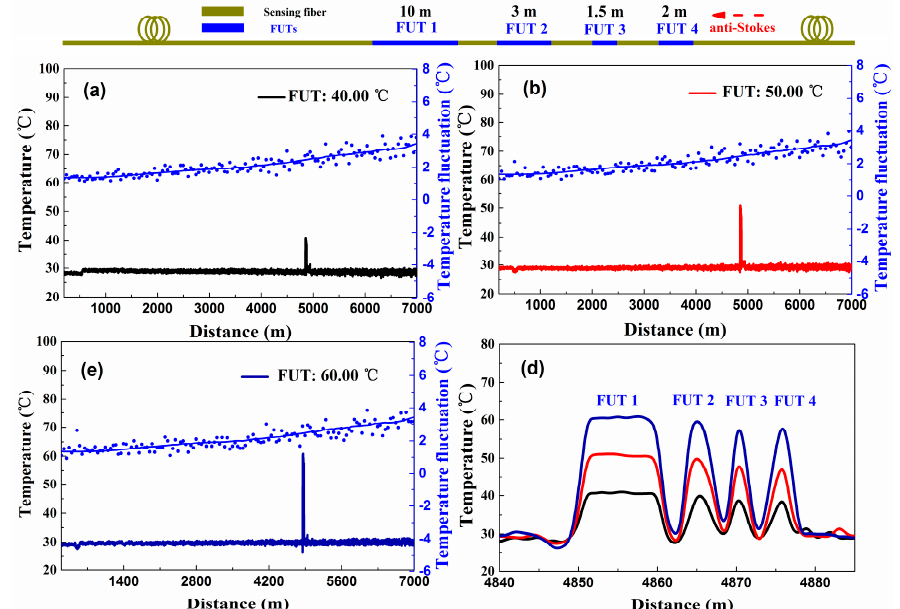
Figure 9. The distributed temperature and temperature resolution measurement for SDP scheme, using the conventional demodulation method under the ( a ) 40.00 °C, ( b ) 50.00 °C, ( c ) 60.00 °C. ( d ) The temperature profiles at the FUTs.